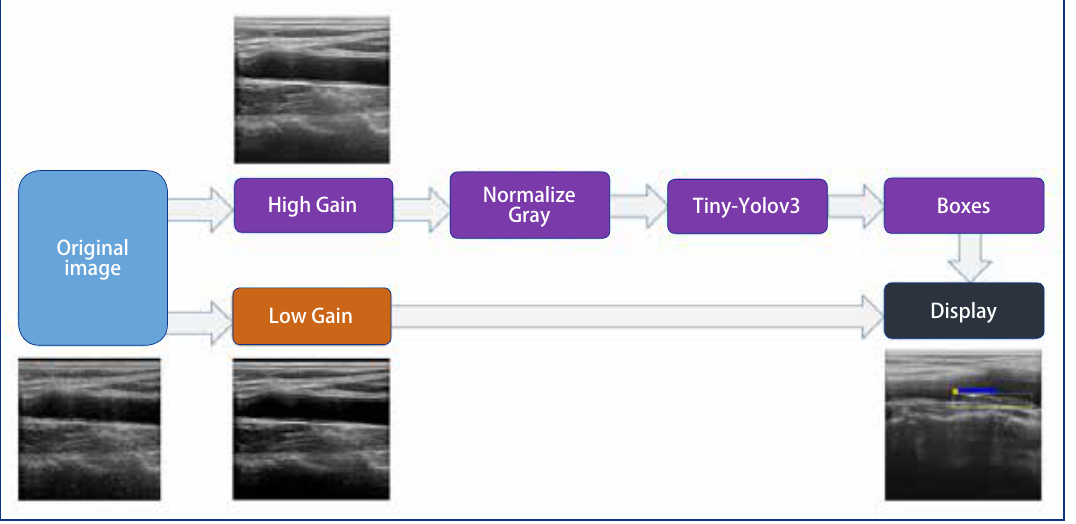
U U ∩ Pred GT U U as IoU = . ∪ Pred U U GT U U